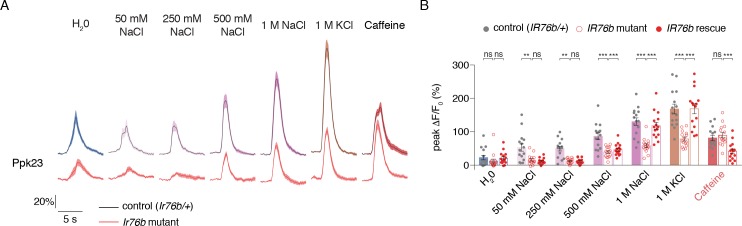
Ppk23 GRN salt responses require IR76b.(A) GCaMP6f fluorescence changes over time for full Ppk23 projections. Black lines are for control genotypes (IR76b1/+ background), red lines for IR76b1/IR76b2 mutants. (B) Peak fluorescence changes during each stimulation. Bars represent mean ±SEM, n = 15. Filled grey circles (control), open red circles (IR76b mutants), and filled red circles indicate values for individual replicates. Asterisks indicate significant difference between control and mutant responses for each stimulus by two-way ANOVA with Bonferroni post hoc test, *p<0.05, **p<0.01, ***p<0.001.